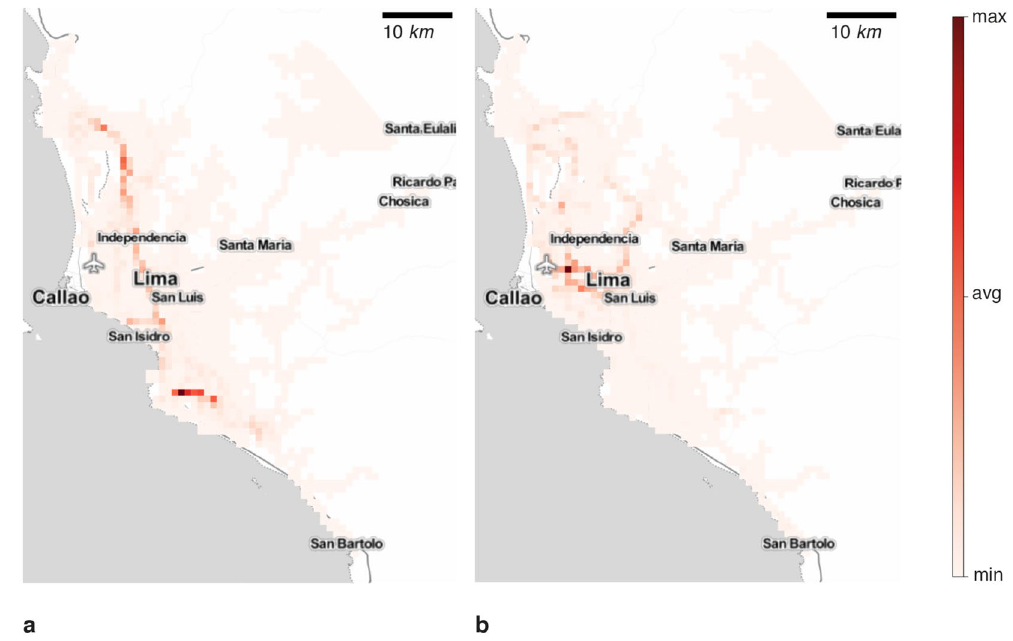
Figure 6. Road infrastructure criticality variation map for Lima. Where ( a ) is the criticality variation in the employed fault line hazard map with a disruption buffer zone of 500 m with a return period of 50 and 100 years, and ( b ) is the criticality variation in the employed flood hazard map of flood planning hazard map at historical return period. ( a ) depicts the highest criticality in the main highway joining Lima north and south. (b) evinces a homogeneous degradation. Maps were created using Map Tiles by Stamen Design, CC BY 3.3 - Map data ©using Contextily 1.2.0 library for Python [maps.stamen.com].